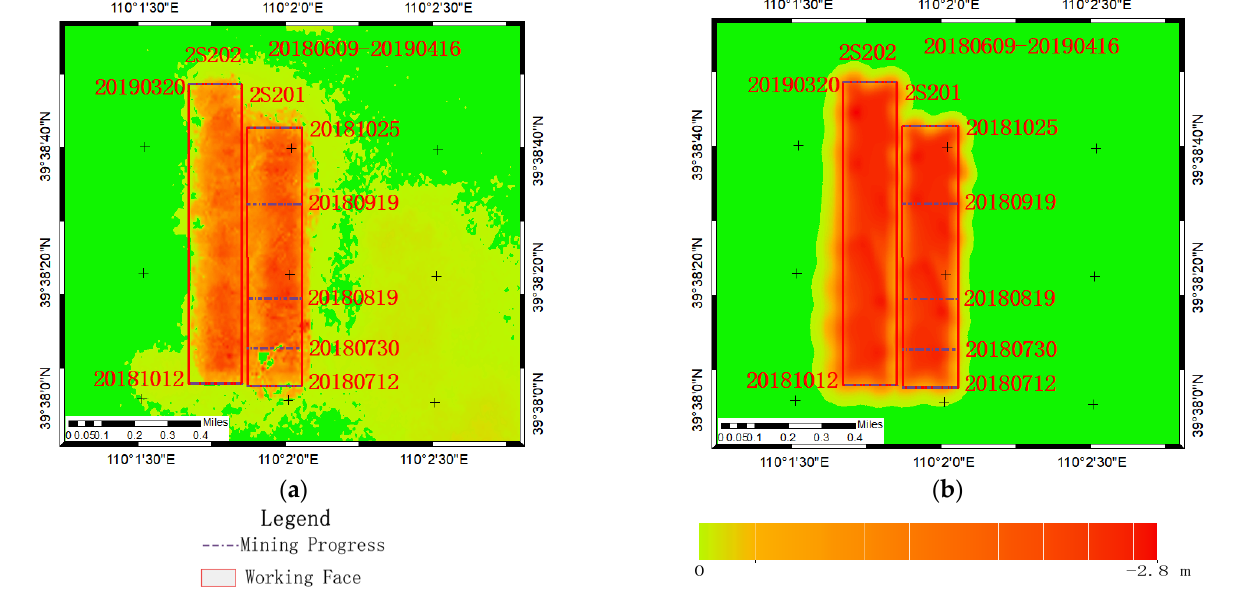
Figure 7. Example of fusion methods. ( a ) Interpolation and superposition subsidence map by SBASInSAR, DInSAR and UAV; ( b ) subsidence map by the fusion method; The date marked in red is the mining time; 2S201 and 2S202 are working faces; the data is of production.